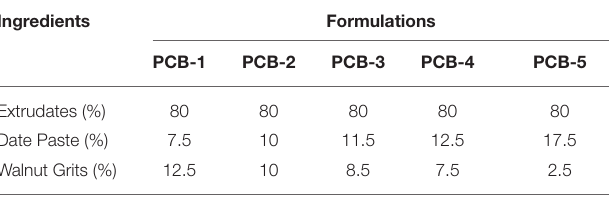
Preparation of Indian Horse Chestnut Flour TABLE 1 | Raw material and proportion used in the development of pregelatinized cereal bars.